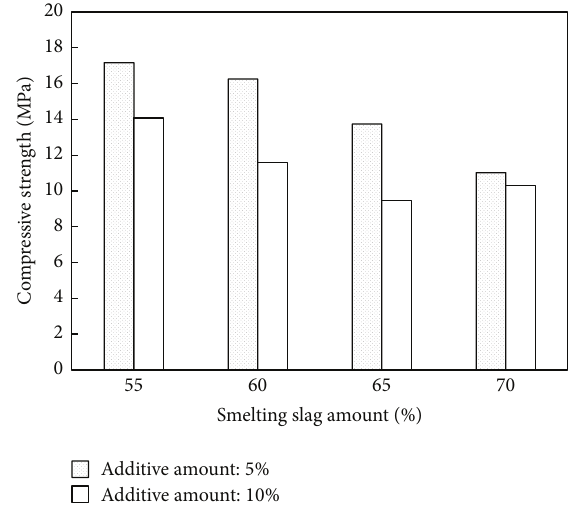
Figure 2: Comparison of compressive strength of smelting slag cementitious materials with different additive content.